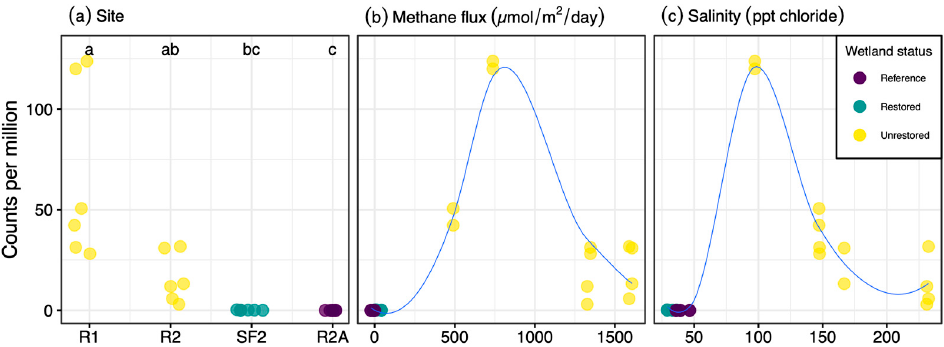
Figure 4. Abundance of Methanosalis sp. SBSPR1A, expressed as counts per million assembled reads, across 24 metagenomic samples from Zhou et al. (2021) [30], organized by ( a ) site, showing the four wetland sites sampled, ( b ) methane flux (µmol/m 2 /day), and ( c ) salinity (ppt chloride). Samples were taken from two unrestored salterns, a restored saltern, and a reference wetland. Lines in ( b , c ) were fitted with loess functions.